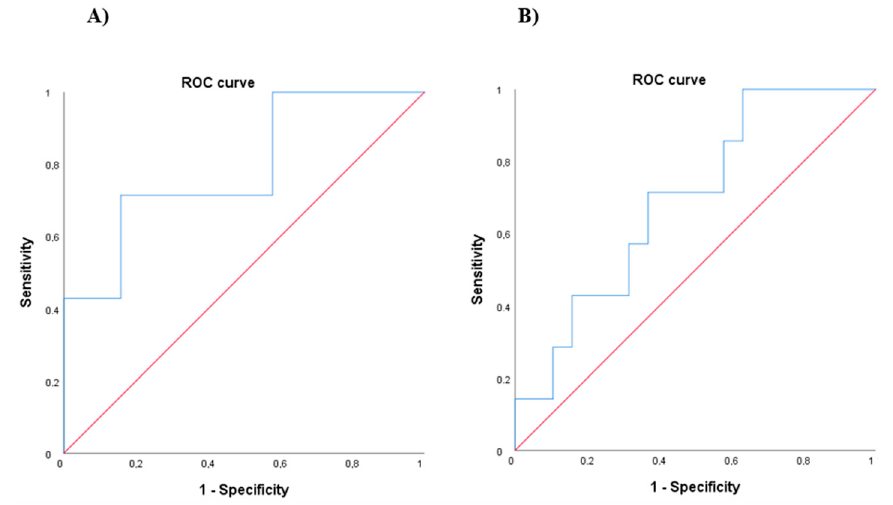
Figure 2. Receiver operating characteristic (ROC) curve for the values of erythema increases after one phototherapy session. ( A ) A receiver operating characteristic (ROC) curve was created to determine the optimal cut-off value of erythema increases after one phototherapy session to predict PASI improvement in patients with psoriasis after fifteen phototherapy sessions (area under curve = 0.789, p = 0.026). An erythema increase exceeding 53.23 AU after the first phototherapy session had high probability of improving PASI by ≥ 3 points after fifteen phototherapy sessions (sensitivity = 71.4%; specificity = 84.2%). ( B ) A receiver operating characteristic (ROC) curve was created to determine the optimal cut-off value of stratum corneum hydration (SCH) increases after one phototherapy session to predict PASI improvement in patients with psoriasis after fifteen phototherapy sessions (area under curve = 0.692, p = 0.140). An SCH increase exceeding 1.06 AU after the first phototherapy session had high probability of improving PASI by ≥ 3 points after fifteen phototherapy sessions (sensitivity = 71.4%; specificity = 63.8%).